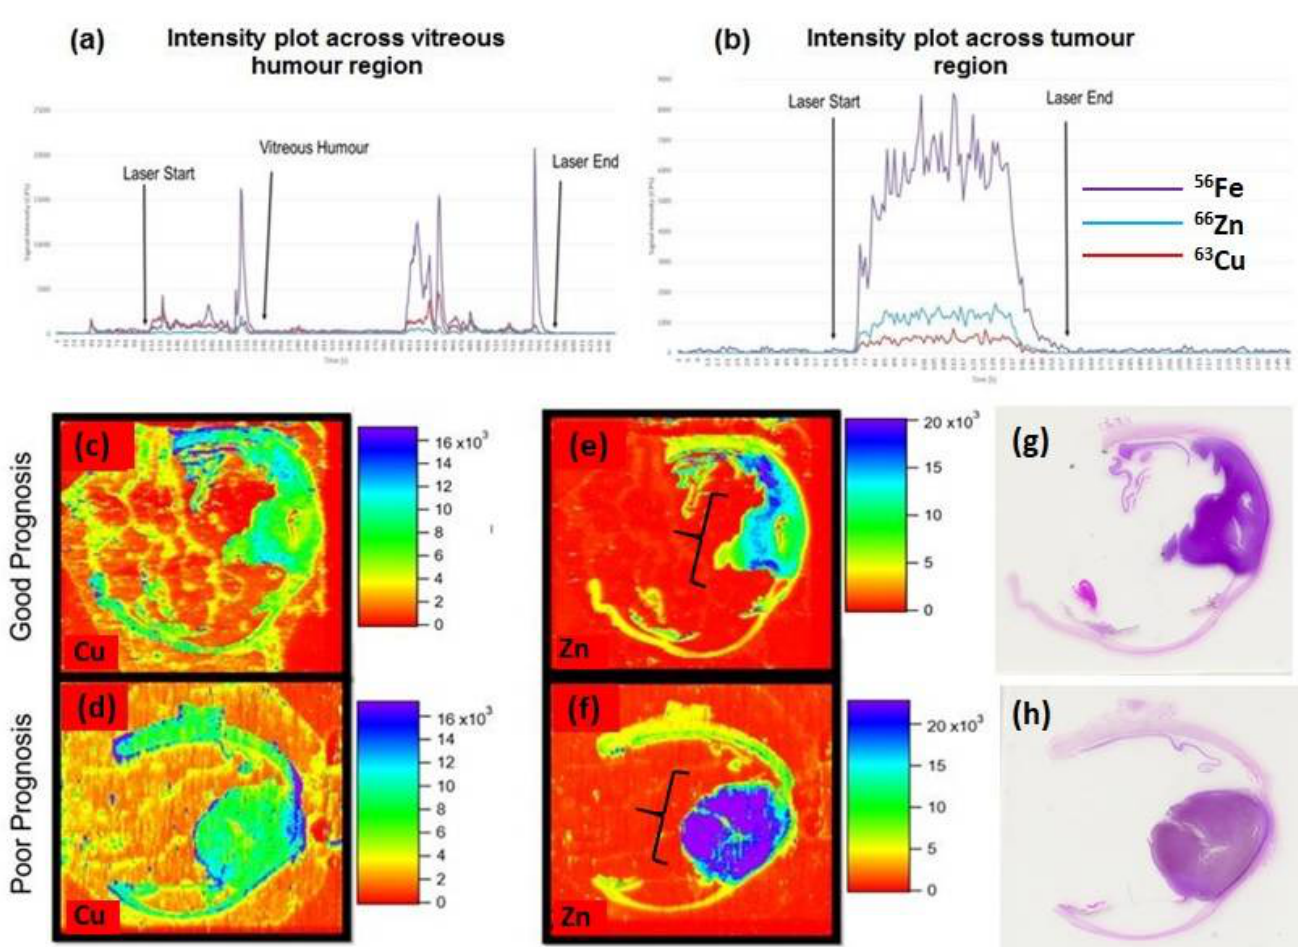
Figure 4. Intensity plots to show counts per second of 63 Cu, 66 Zn and 56 Fe across one line of ( a ) whole eye section and ( b ) UM tumour region, acquired in KED mode. Spatial elemental distribution of elements in uveal melanoma sections, recorded as counts per second (CPS). ( c , d ) display copper ( 63 Cu) distribution of good and poor prognosis, respectively (see patient E (good) and H (very poor) in Table 1), ( e , f ) show zinc ( 66 Zn) distribution of good and poor prognosis, respectively, tumour mass is indicated by the brackets and the corresponding H&E stained sections are shown in ( g , h